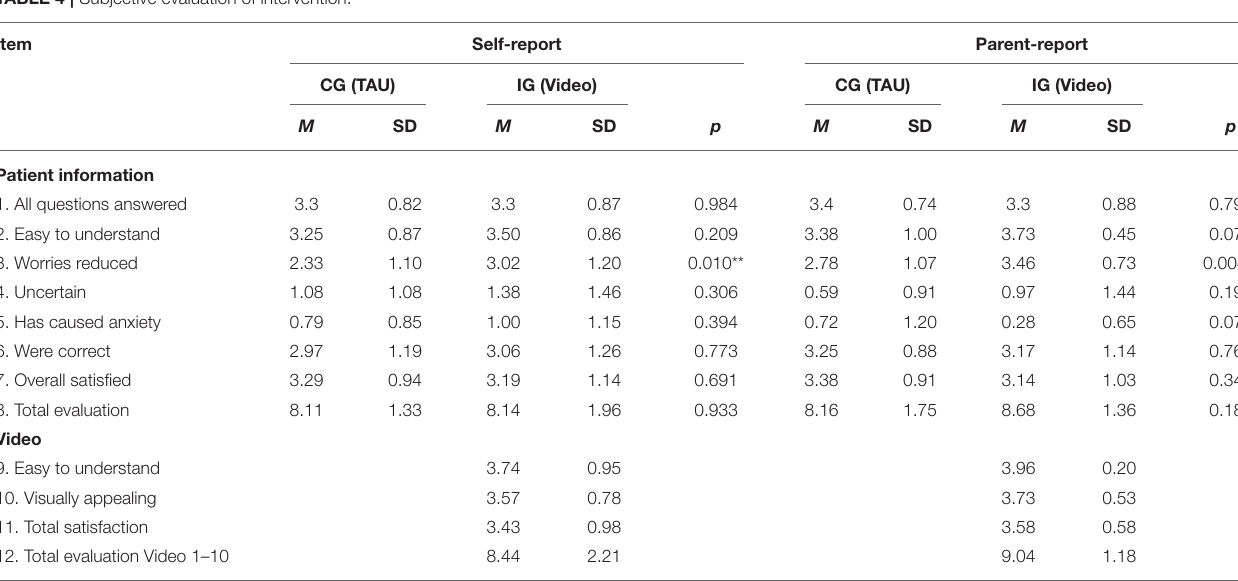
TABLE 4 | Subjective evaluation of